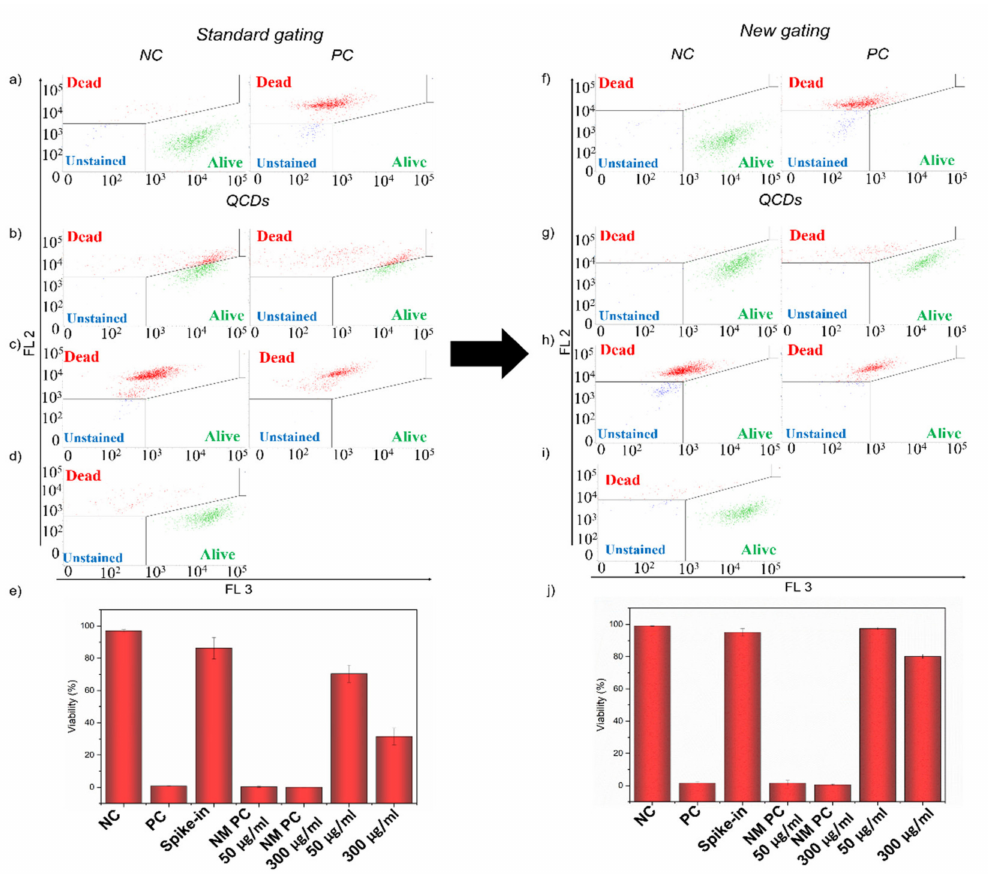
Figure 4. Dot plot showing LIVE/DEAD assay of: ( a , f ) negative and positive control of BJ cells and ( b – d , g – i ) BJ cells treated with QCDs samples with ( a – d ) standard gating and ( f – i ) new gating approach. ( b , g ) Samples treated with 50 µ g/mL ( left ) and 300 µ g/mL ( right ) of QCDs for 24 h; ( c , h ) Samples treated with NM PC 50 µ g/mL ( left ) and NM PC 300 µ g/mL ( right ); ( d , i ) Spike-in control for QCDs. ( e , j ). The evaluation of the viability of BJ cells treated with QCDs and additional control samples ( n = 3). The events in the alive gate are shown in green, events in the dead gate in red and events in the unstained gate are highlighted in